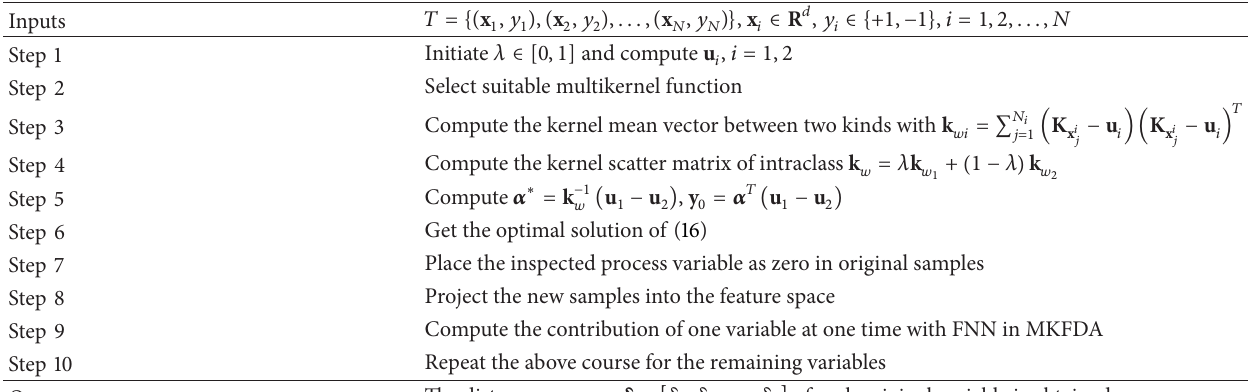
Table 1: Steps designed in this